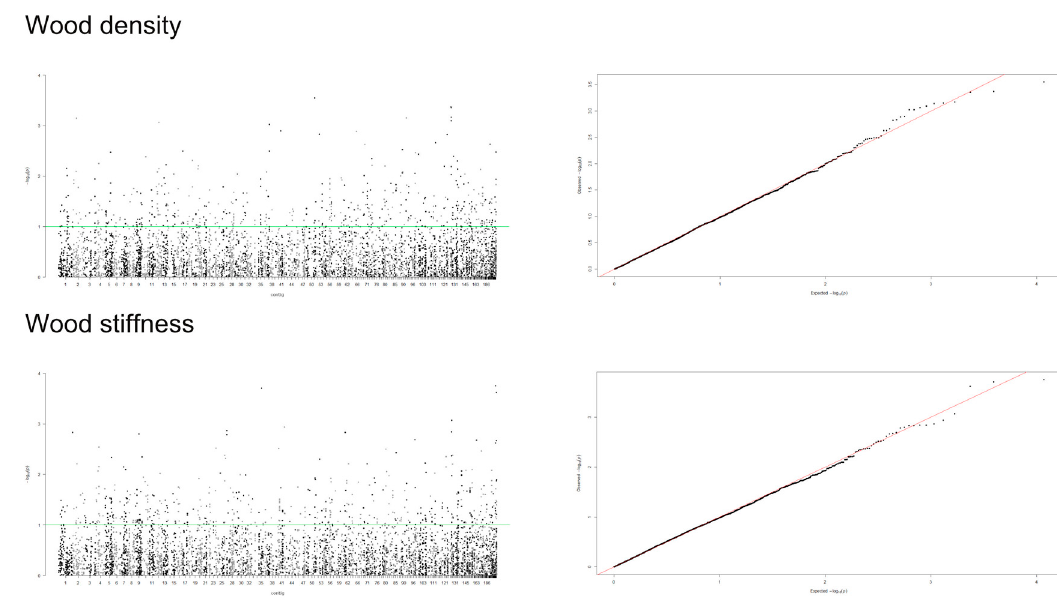
Figure 6. Manhattan and Q-Q plots for genome-wide association of S. platyclados wood quality traits with SNP markers of Q + K model. The quantile-quantile plot indicates the fitness between expected (red lines) and observed p -values (black dots).